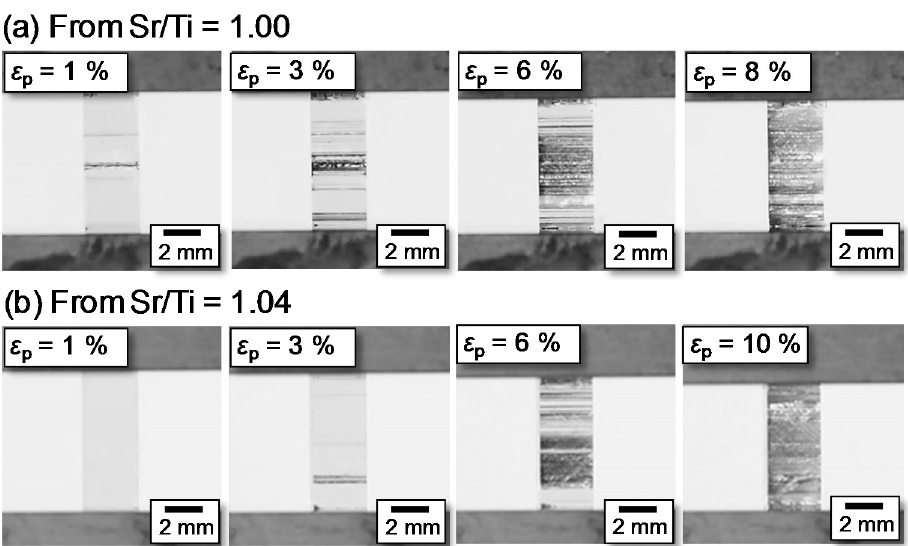
Figure 3. Shapes and surface morphologies of the deformed specimens. ( a ) The Sr / Ti = 1.00 specimen deformed at (cid:2013)(cid:4662) = 1.0 × 10 − 1 (s − 1 ). ( b ) The Sr / Ti = 1.04 specimen deformed at (cid:2013)(cid:4662) = 1.0 × 10 − 1 (s − 1 ). Here, each (cid:2013) p in the figures indicates the plastic strain.